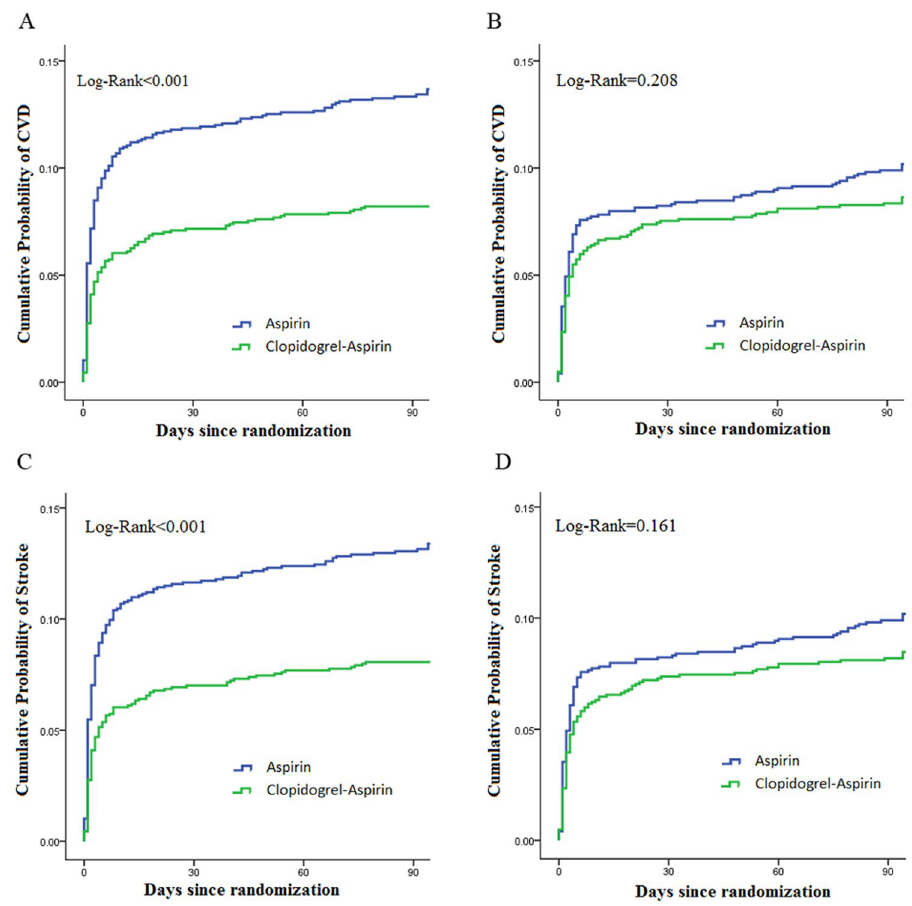
Figure 2. Kaplan-Meier curves showing the time to stroke outcomes in patients with DBP ≥ 90 mmHg or DBP < 90 mmHg, treated with clopidogrel-aspirin or aspirin alone. ( A ) Cumulative probability of CVD by treatment among patients with DBP ≥ 90 mmHg; ( B ) Cumulative probability of CVD by treatment among patients with DBP < 90 mmHg; ( C ) Cumulative probability of stroke by treatment among patients with DBP ≥ 90 mmHg; ( D ) Cumulative probability of stroke by treatment among patients with DBP < 90 mmHg. Abbreviations: CVD = combined vascular events (ischemic stroke, hemorrhagic stroke, myocardial infarction, or vascular death); DBP = diastolic blood